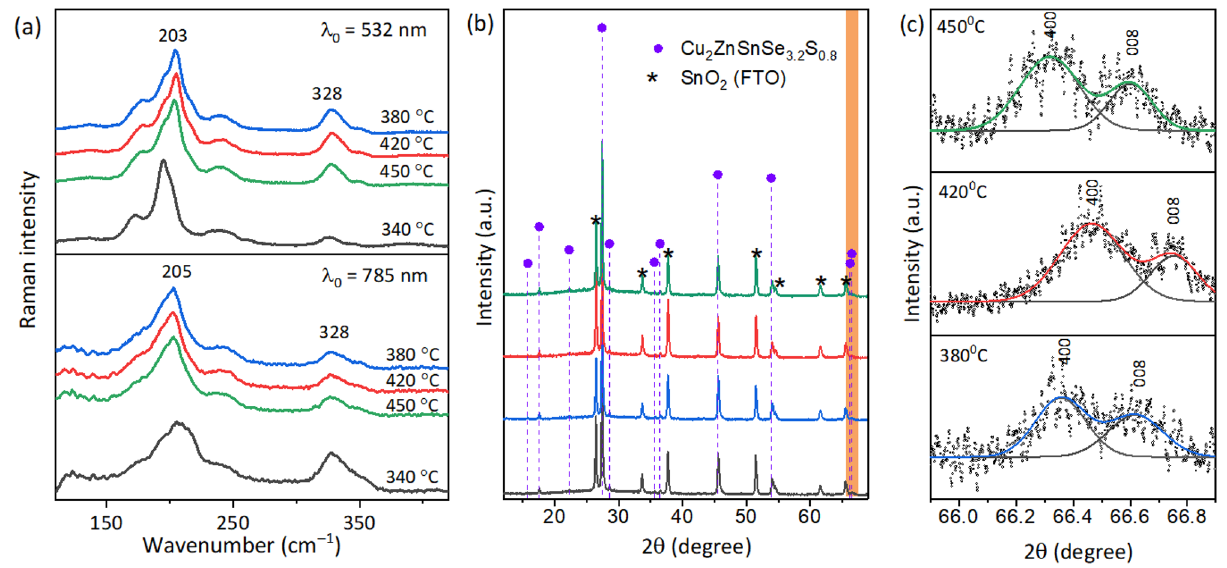
Figure 4. Material quality of CZTSSe films. ( a ) Raman spectra of CZTSSe as-deposited and later annealed at different temperatures in sulfur atmosphere and finally with selenium. The spectral range of 110–400 cm-1 was fitted using Gaussian–Lorentzian shape components. ( b ) the XRD patterns of CZTSSe films obtained after the selenization at temperature of 540 °C of the as-deposited CZTS films and CZTS films sulfurized at temperatures of 380, 420, 450 °C. ( c ) The fragments of XRD patterns measured with Cu Kα1 radiation representing peaks 400 and 008 of CZTSSe after the selenization at temperature of 540 °C of the CZTS films sulfurized at temperatures of 380, 420 and 450 °C.